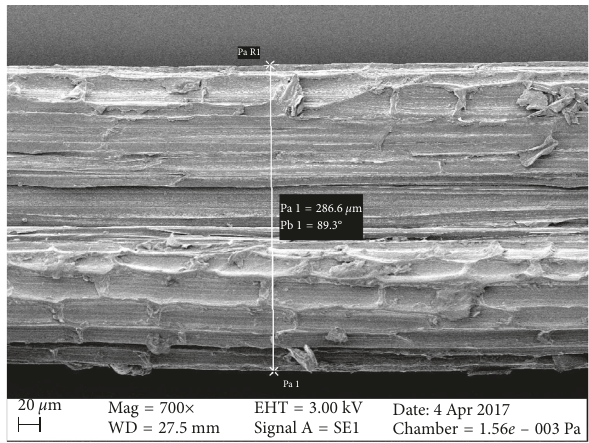
Figure 2: Untreated sisal